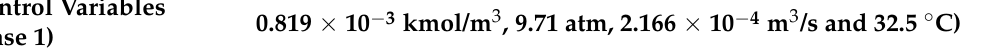
Table 2. Optimisation results of the